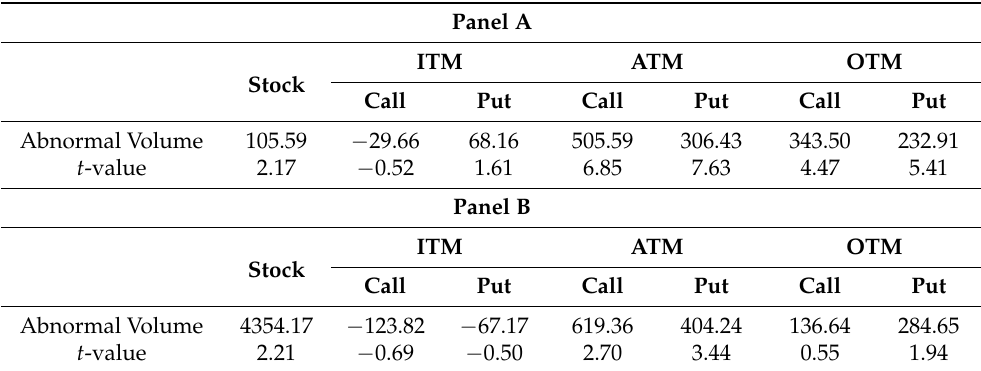
Table 5. Abnormal Trading of Rival